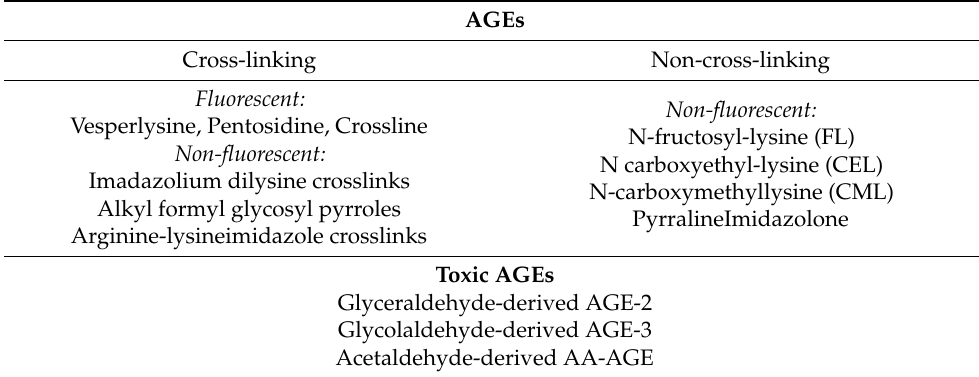
Table 1. AGEs and Toxic AGEs: Types and examples. AGEs Cross-linking Non-cross-linking Fluorescent: